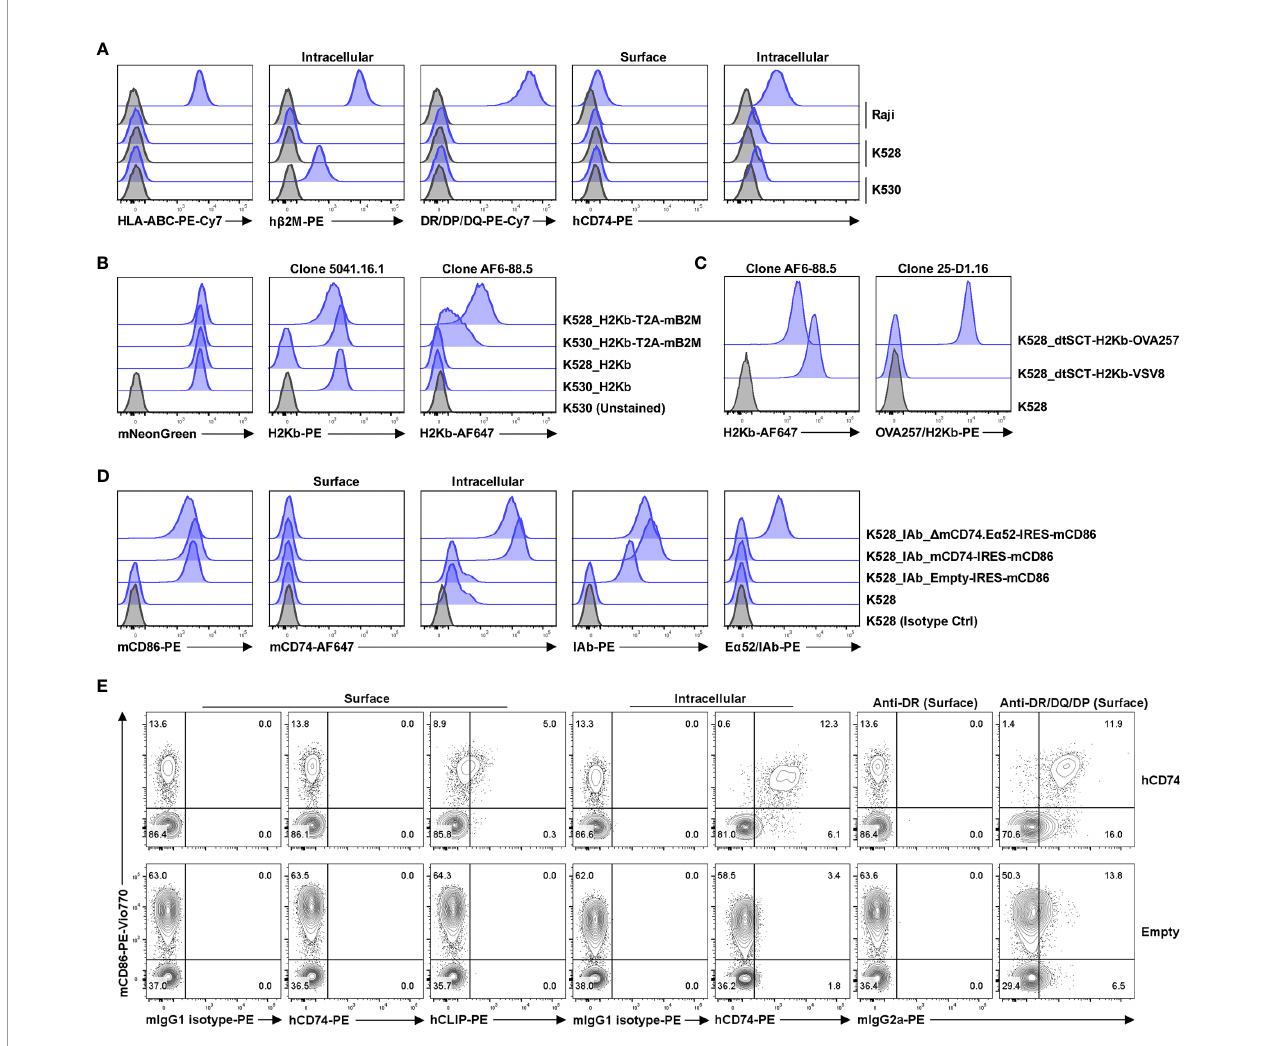
FIGURE 1 | K528 is a versatile cell line for transgenic expression of MHC class I and II molecules from different mammalian species. (A) Phenotypic analysis of K528 cell line. K530 and Raji cells were used as controls in straining. The gating strategy is shown in Figure S2 ; similar gating strategies were applied to other panels below. Grey histograms show staining with isotype control antibodies. (B) K528 and K530 cells were transduced to express H2Kb with or without co-expressed mouse b 2M molecules. The expression vectors co-express mNeonGreen as a selection marker. Monoclonal cell lines with comparable mNeonGreen fl uorescence intensities were selected for comparison. Cell surface expression of H2Kb molecules were detected with either mouse b 2M-independent (clone 5041.16.1) or -dependent (clone AF6-88.5) antibodies. (C) K528 cells were transduced to express single-chain trimer with disul fi de trap (dtSCT) structures of H2Kb molecules with either VSV8 or OVA257 peptides. Surface expression of H2Kb and H2Kb molecules presenting OVA257 peptides were detected with relevant antibodies. (D) K528 cells were transduced to express IAb molecules. The resultant monoclonal cell line was further transduced with lentiviral vectors with expression cassettes Empty- IRES-mCD86 (K528-IAb), mCD74-IRES-mCD86 (K528-IAb-mCD74) or D mCD74.E a 52-IRES-mCD86 (K528-IAb- D mCD74.E a 52) in which the core CLIP sequences were replaced with IAb presenting peptide E a 52 from IEd molecule. Monoclonal cell lines expressing comparable levels of mCD86 were selected for analysis. Surface and intracellular mCD74, surface IAb and E a 52/IAb complex were detected by FACS. (E) K528 cells expressing HLA-DQA1*05:01/DQB1*02:01 were transduced with lentiviral vectors with expression cassettes hCD74-IRES-mCD86 (hCD74) or Empty-IRES-mCD86 (Empty). Bulk cell lines after transduction were used for detection by